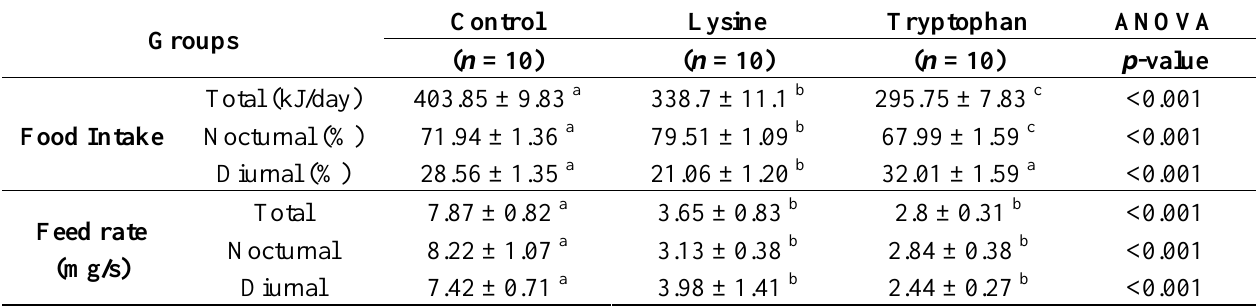
Table 3. Food intake and feeding rate of rats fed on diets supplemented with 5% lysine or tryptophan.